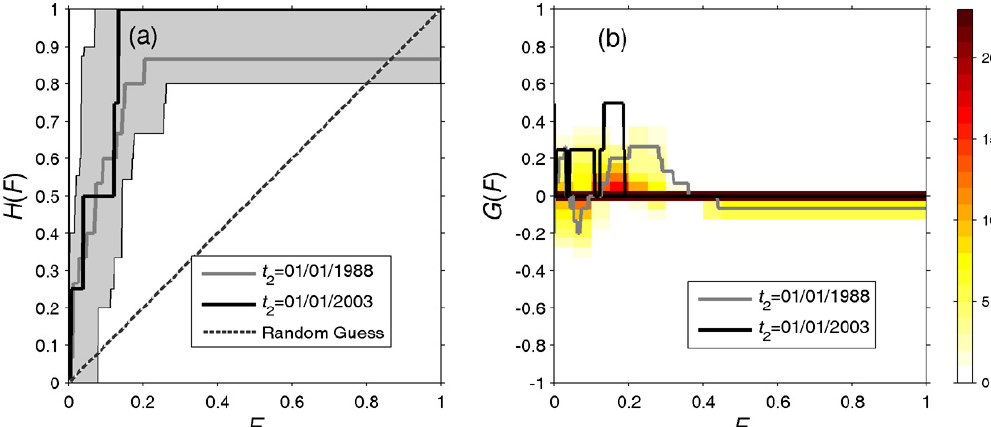
Fig. 3. ROC test of the PI algorithm using “background events”. “Anomaly identifying window” and “forecast window” are taken both as 5 years. The “sliding window” is taken as 15 years. “Forecast window” slides from t 2 =1 January 1988 to t 2 =1 January 2003, with sliding step being 0.5 year. (a) ROC curve. Gray zone delimits the range of all the ROC curves, with gray line and black line representing the results of the first and the last sliding, respectively. (b) Difference between the hit rate of the PI algorithm and RI algorithm. The gray line and black line represent the results of the first and the last sliding, respectively. The color bar indicates the stacking of the areas encompassed by the G curves and the horizontal zero-line.